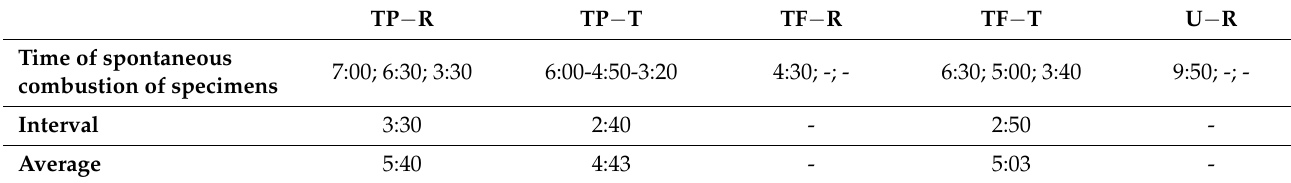
Table 6. Time of spontaneous combustion of individual specimens.